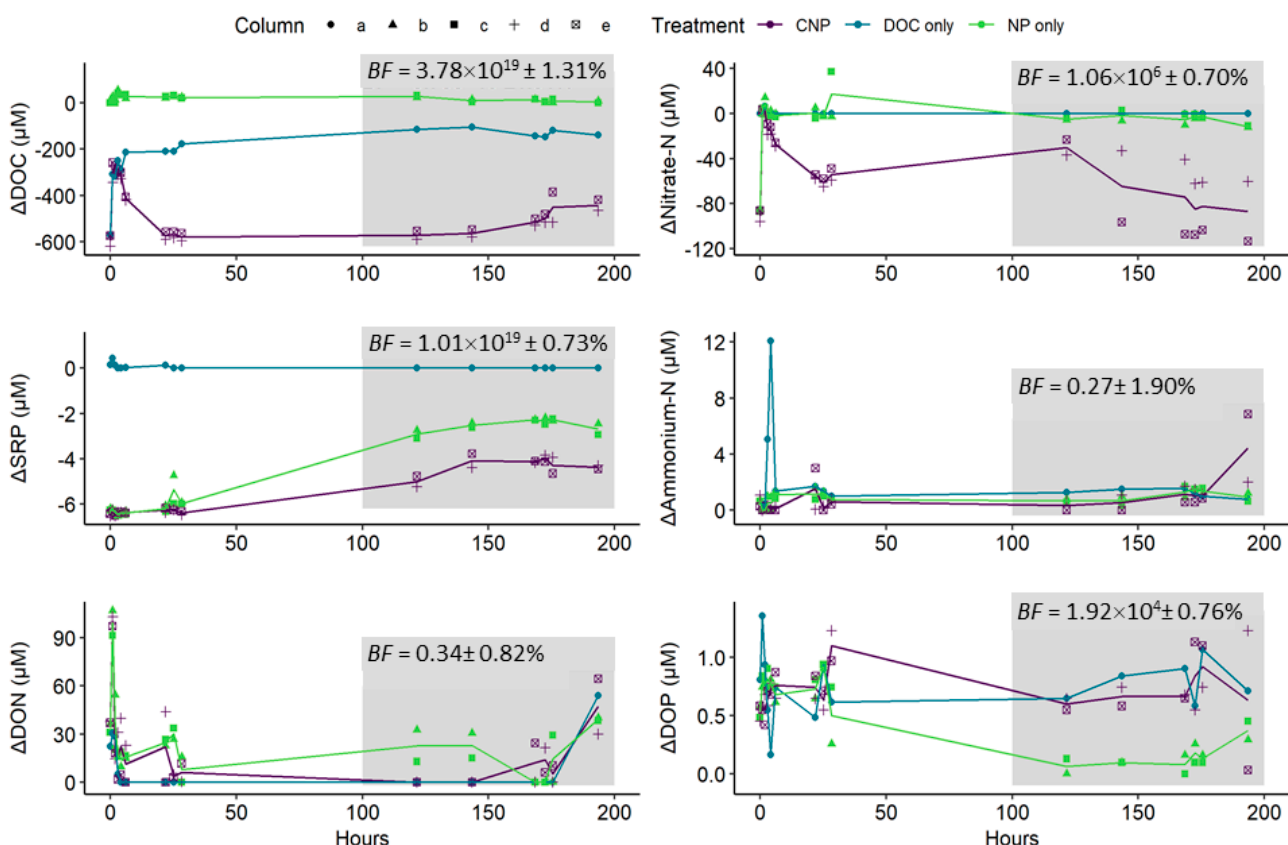
Figure 2. Outflow minus inflow concentrations of dissolved organic carbon (DOC), NO 3 -N, soluble reactive P (SRP), NH 4 -N, dissolved organic nitrogen (DON) and dissolved organic P (DOP) for the five columns (data points) and average lines for the three Table 200 h of leaching (~600 PV equivalents). The shaded area from 100 to 200 h represented the relatively stable period during which the Bayes factor statistic ( BF ; with relative % accuracy) was derived to denote evidence that concentrations during that period differed between treatments (insignificant evidence of difference for DON and NH 4 -N, whereas very strong evidence in all other cases). It should be noted that DON and DOP analytical data were characterized as susceptible to high random errors in 47% of samples with high DIN:TDN and 21% of samples with high SRP:TDN (Section 2.3).